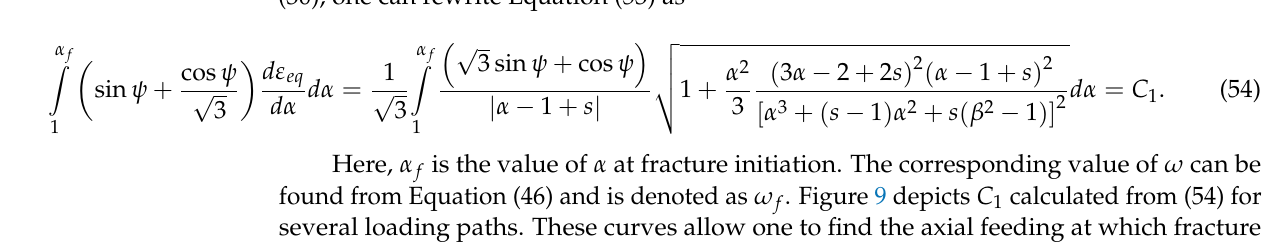
Here, ψ is understood to be calculated from Equation (35) at µ = β 2 . Using Equation (30), one can rewrite Equation (53) as